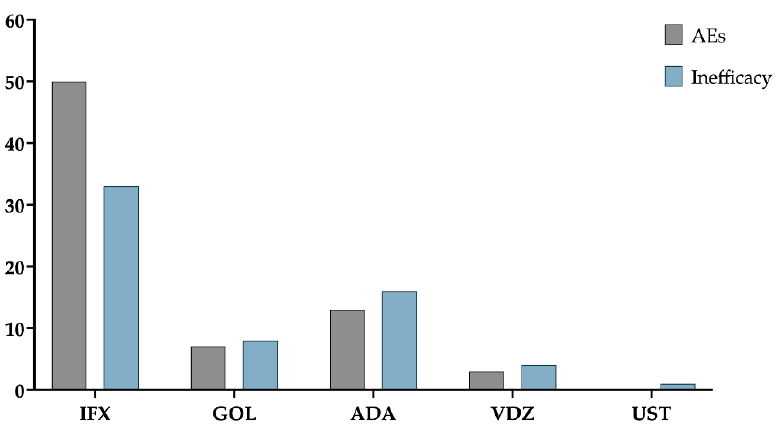
Figure 1. Patients with adverse events (AEs) and inefficacy. IFX: infliximab; ADA: adalimumab; GOL: golimumab; VDZ: vedolizumab; UST: ustekinumab.